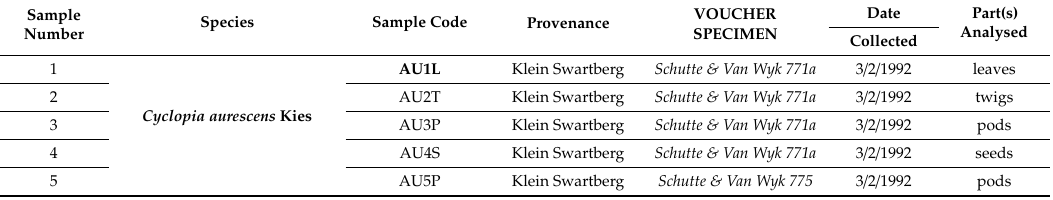
localities, numbered from West to East per